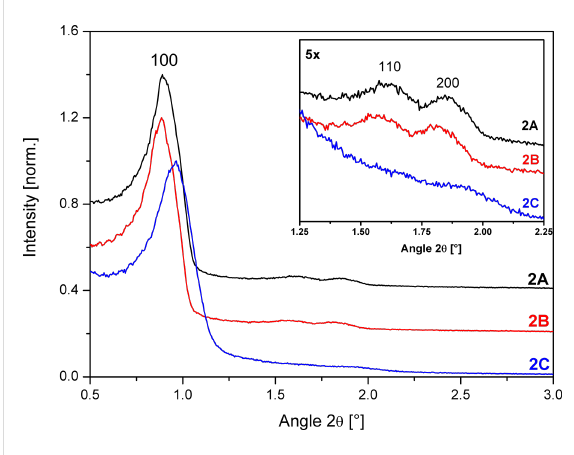
Figure 8: N 2 adsorption/desorption isotherms of SBA-15 sample 3 devided into a 1× half batch unwashed ( 3A ), after washing with 5 mL ( 3B ) and 30 mL ( 3C ), a 3× half batch washed with 120 mL ( 3D ) and a 9× half batch washed with 350 mL ( 3E ) quantities of solvent. The isotherms are offset by 1100 ( 3A ), 700 ( 3B ), 500 ( 3C ), 300 ( 3D ) cm 3 /g.